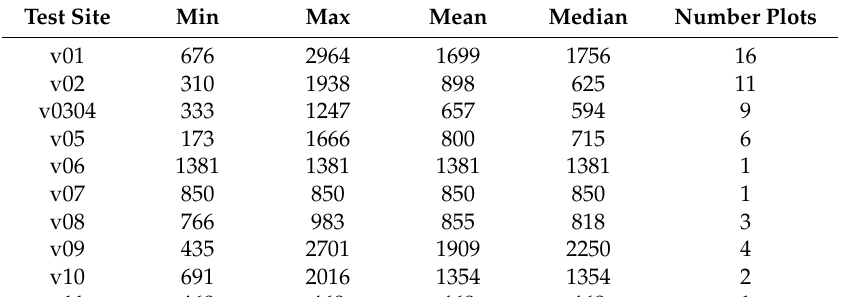
Table 2. Forest plot densities in the study area. Densities are presented as trees per hectare.